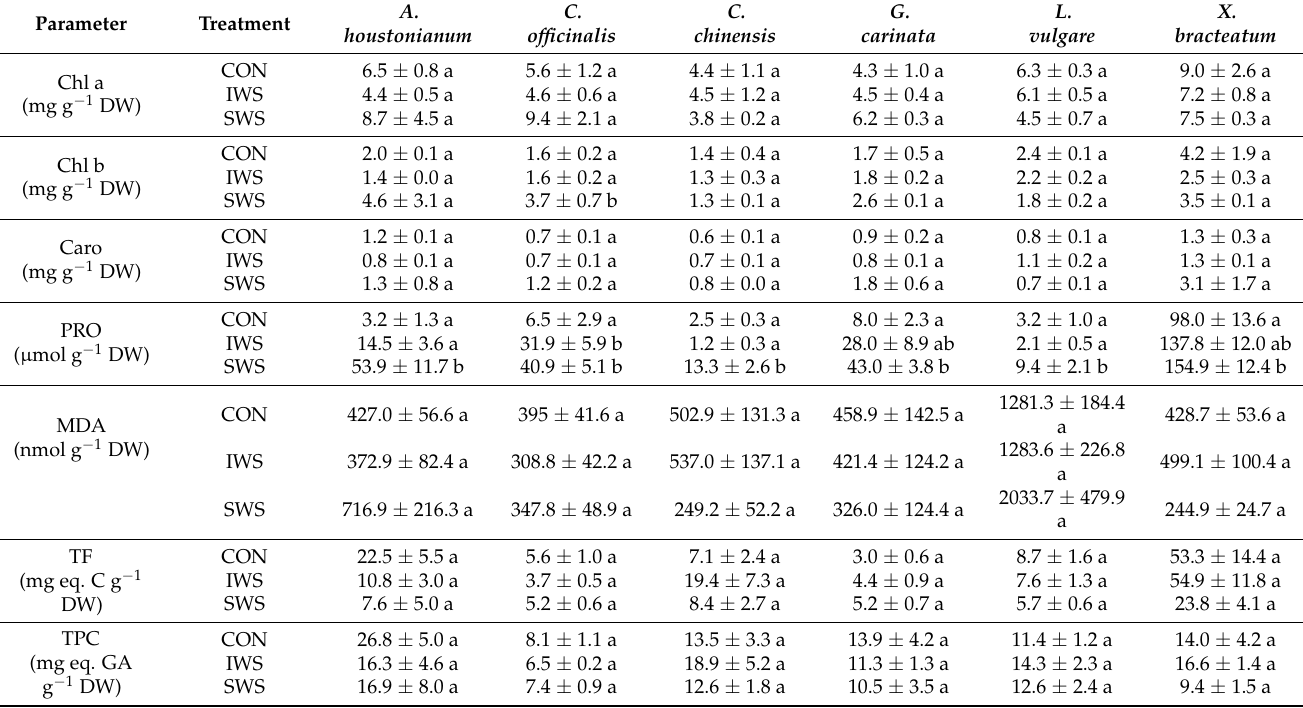
Table 2. Effect of intermediate water stress (IWS) and severe water stress (SWS) on the measured photosynthetic pigments, osmolytes, and antioxidant compounds. Mean values ± SE ( n = 5) of chlorophylls a and b (Chl a and Chl b), carotenoids (Caro), proline (PRO), malondialdehyde (MDA), total phenolic compounds (TPC), and total flavonoids (TF) contents. Different lowercase letters indicate significant differences between treatments for each species and measured parameter, according to the Tukey test ( p < 0.05). GA: gallic acid; C: catechin.